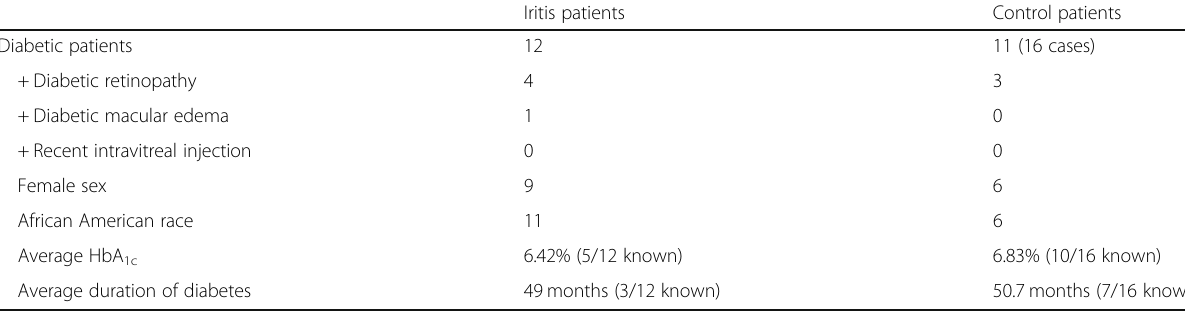
Table 2 Comparison of diabetic history and demographics between the iritis and control